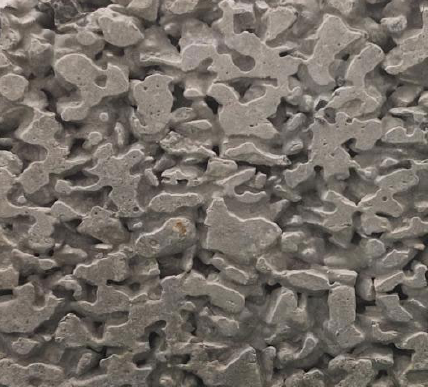
Figure 10. Permeable concrete internal structure.